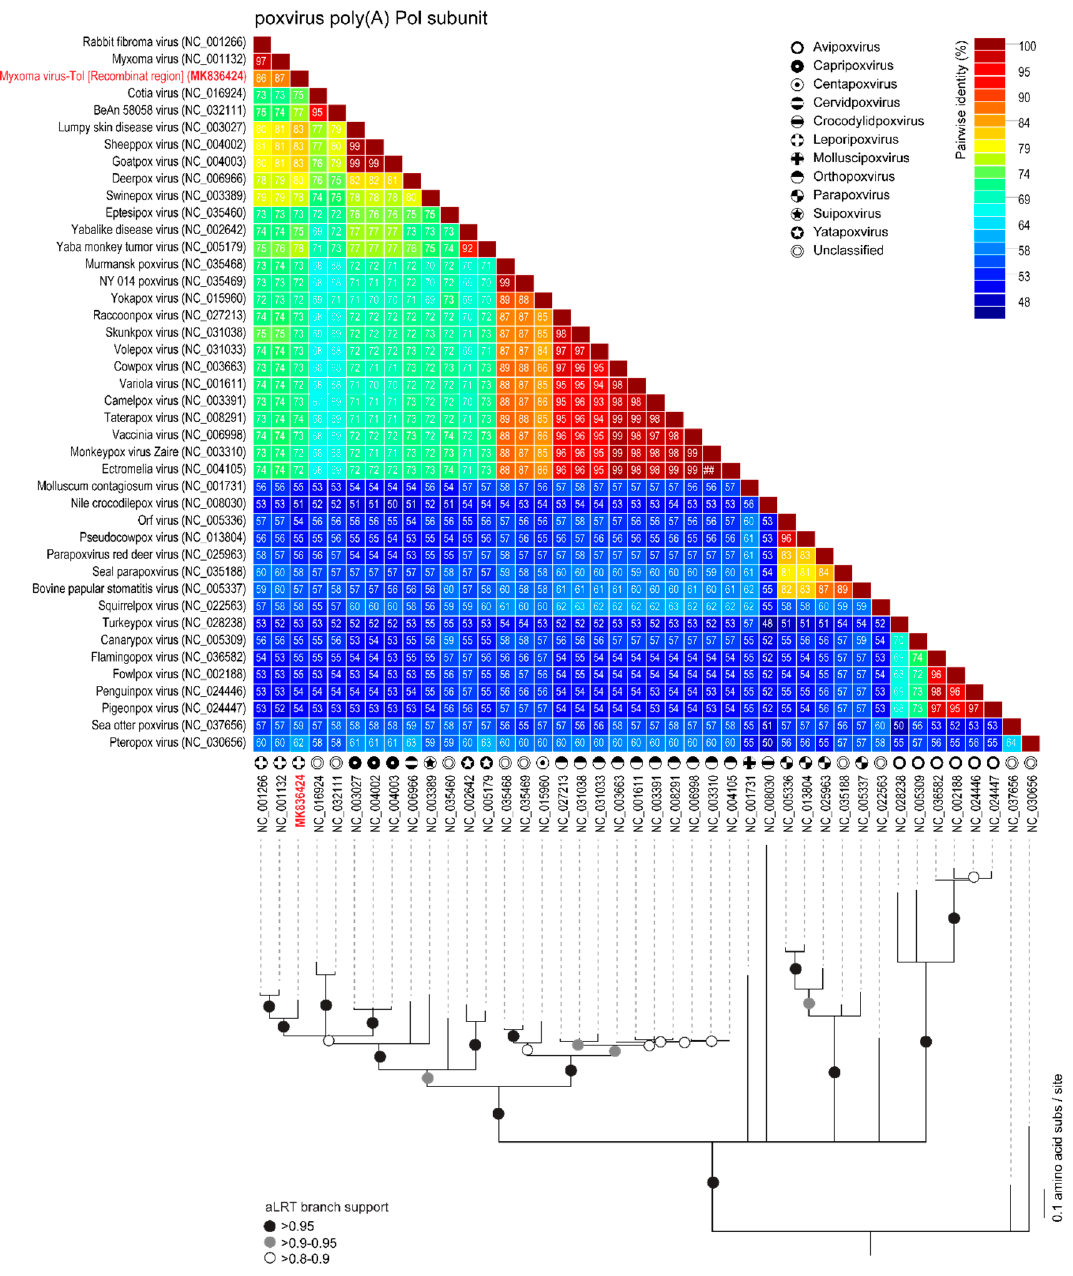
Figure 8. Pairwise amino acid identity matrix (upper image) and maximum-likelihood phylogenetic tree (model JTT+G+F) showing the relationships of the rPox-poly(A) Pol subunit (highlighted in red), found in the recombinant region of MYXV-Tol, and its homologous proteins, found in the representative sequences (NCBI RefSeq) of poxvirus. Branches with aLRT support 0.95 are indicated by black circles whereas branches exhibiting 0.9–0.95 and 0.8–0.9 are indicated by grey and white circles, respectively.